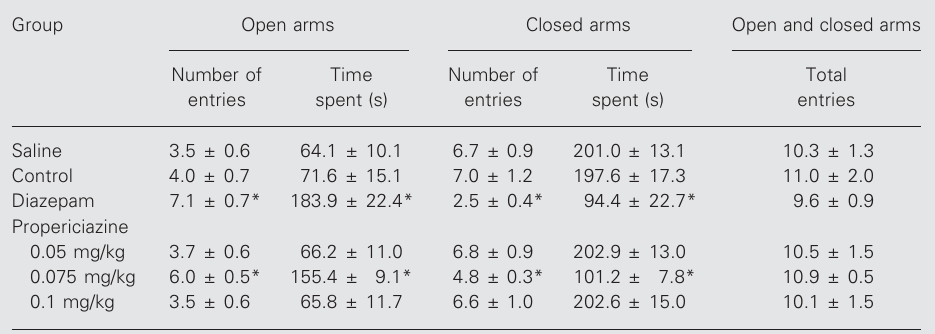
Table 1. Effect of pretreatment of rats with propericiazine on elevated plus-maze behavior.